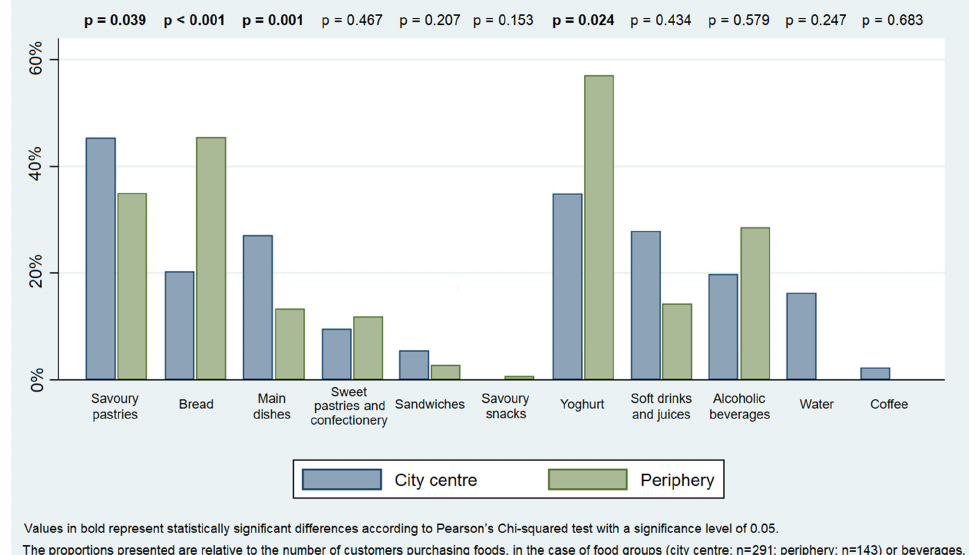
Figure 6. Distribution of ( a ) street food purchases and ( b ) takeaway food purchases, by city location.